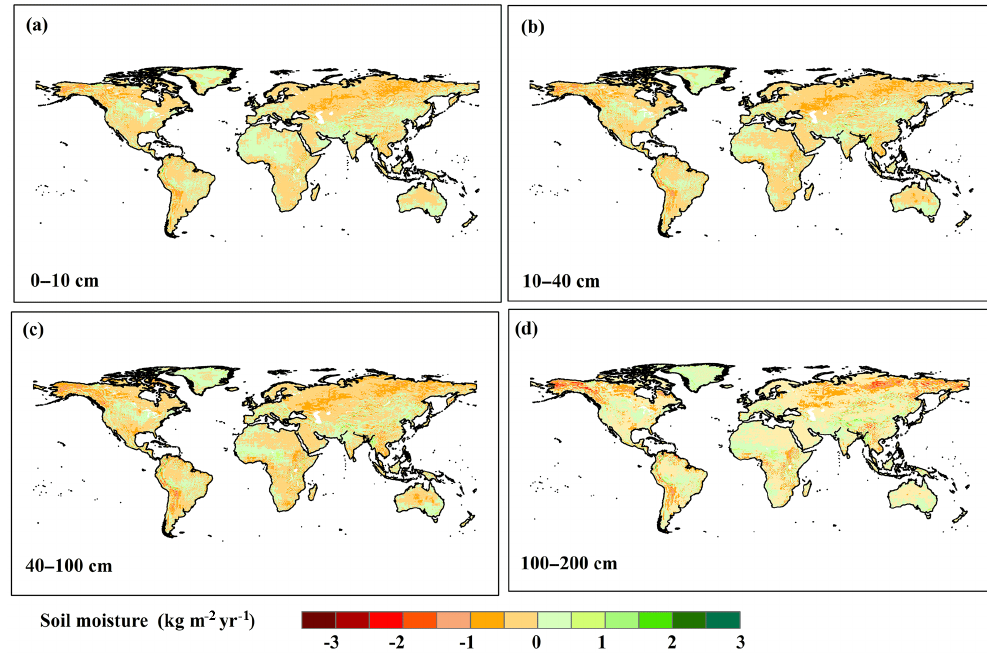
Figure 5. Trends of soil moisture in layers with different depths in 2000–2014.